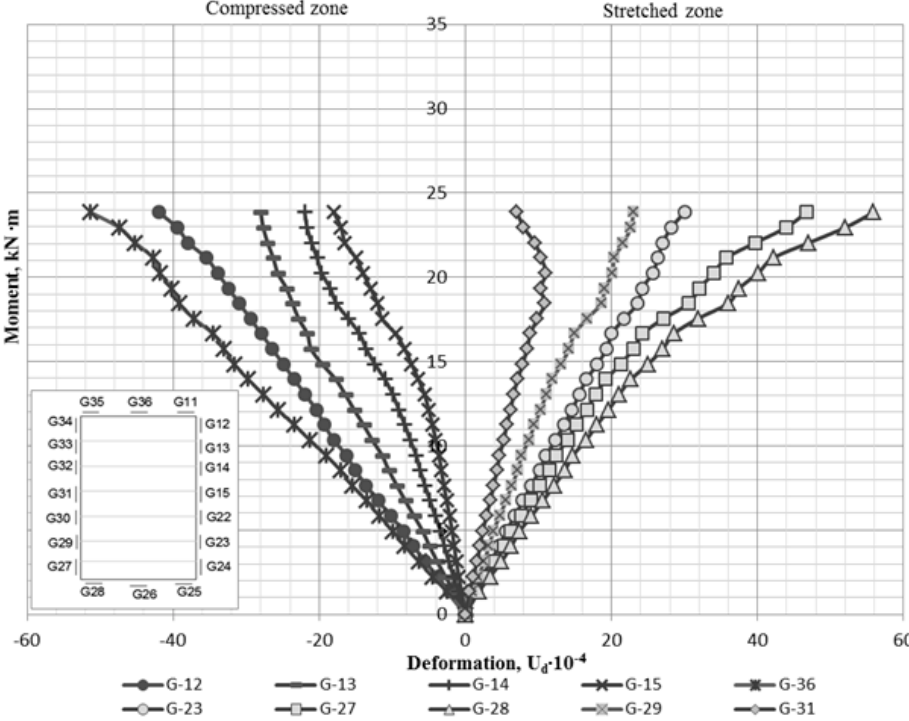
Figure 3. Graphical chart of layer deformation of cross-section fibers of GB-A beam in span middle.